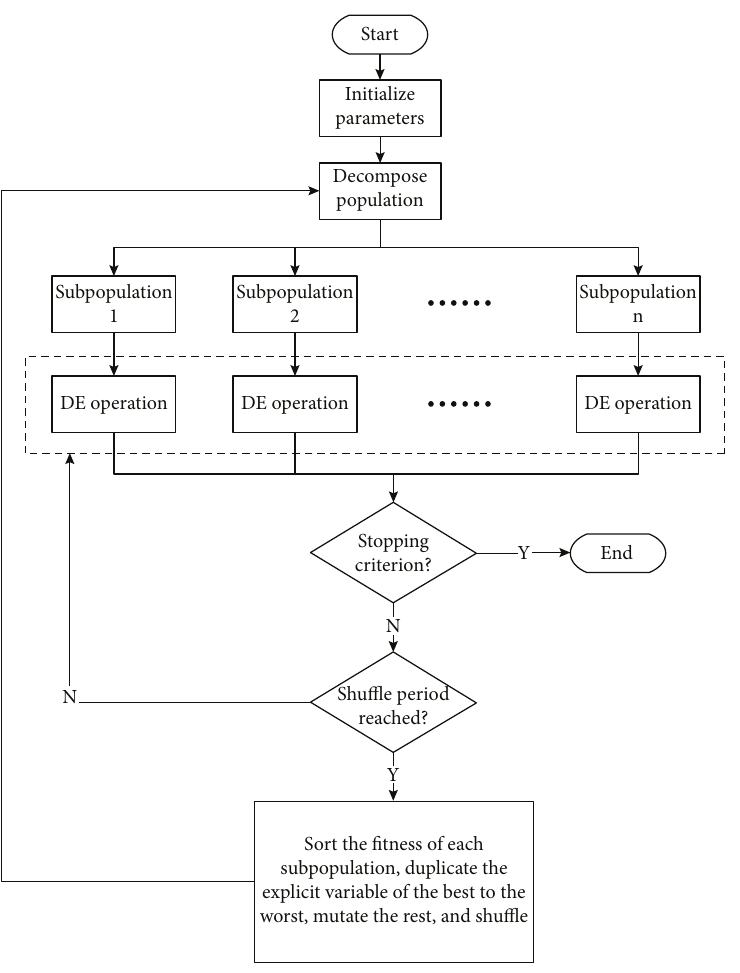
Figure 1: The fl owchart of MSDE. Table 1: Parameters for population decay and state transition